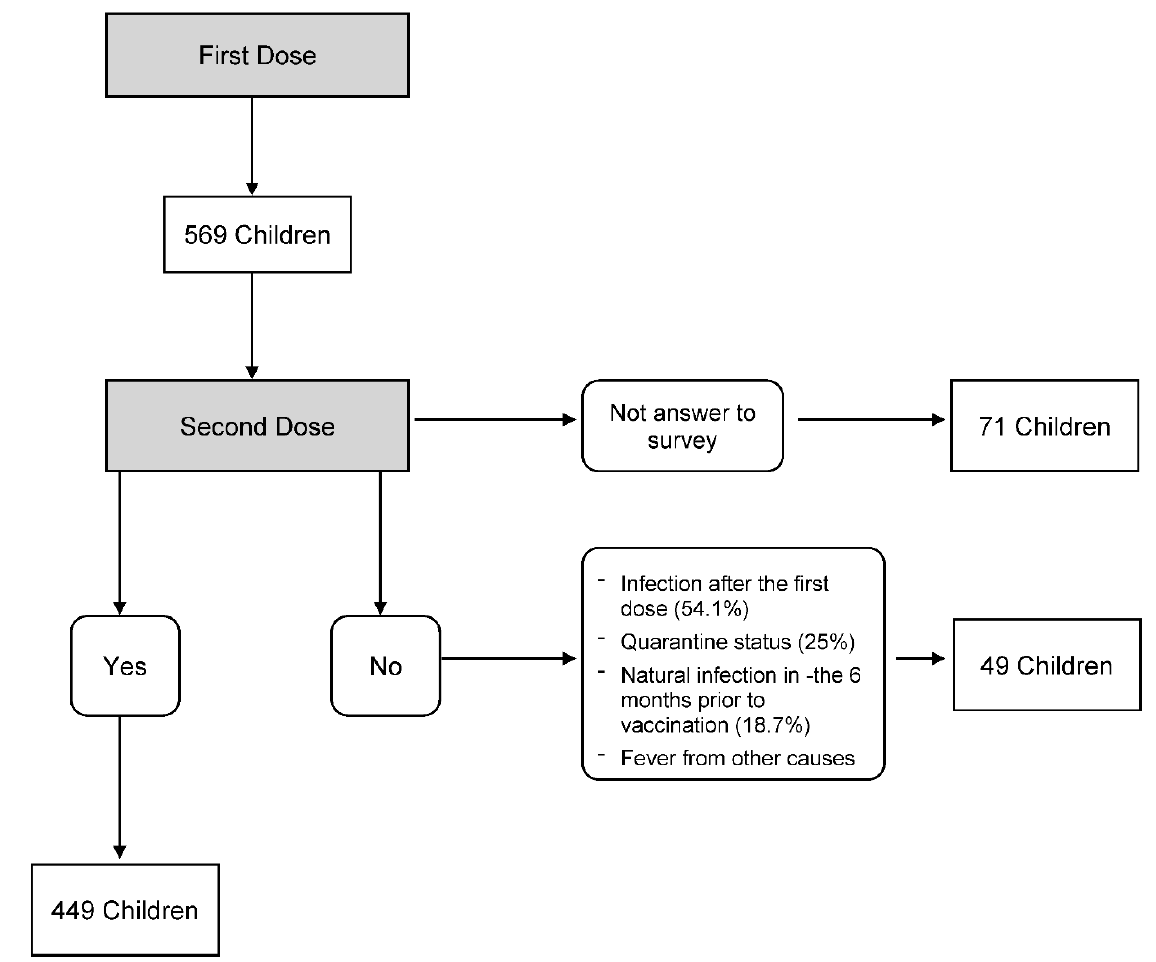
Figure 2. Flowchart patients enrolled.